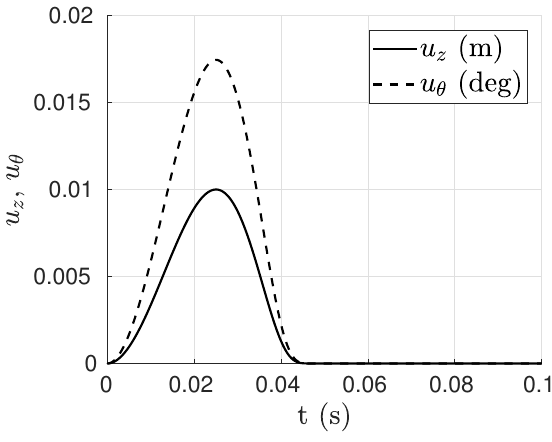
Figure 1. Heave u z and pitch u α pitch input.